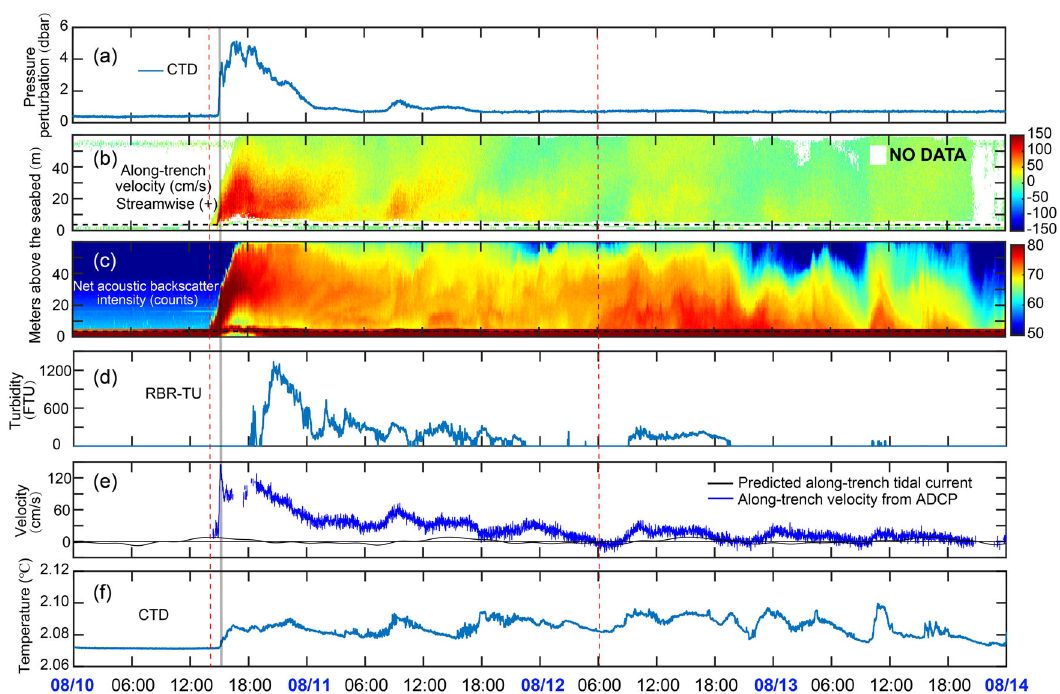
Fig. 3 Plots of the time-series measurements of the turbidity current E2 at the mooring site S2. a Pressure perturbation (dbar) measured by CTD at 17 MAB. b Along-trench current velocity (cm s − 1 ) and ( c ) net acoustic backscatter intensity (counts) (averaged over four beams) recorded by the downward- looking ADCP. d Time-series of turbidity measured by the RBR-TU at 72 MAB. e Along-trench current velocity (cm s − 1 ) at 12 MAB (dark blues line) recorded by the downward-looking ADCP and predicted along-trench tidal current velocity (black line). f Time-series of temperature measured by CTD at 17 MAB. The red dashed lines indicate the beginning and end of the turbidity current.